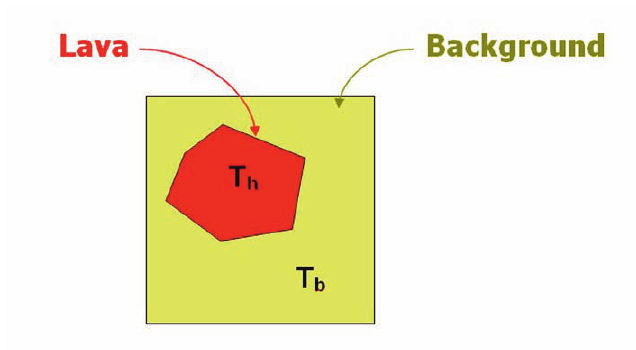
Figure 3. The dual-band method. This assumes that a pixel is occupied by two thermal components: a high-temperature component at temperature T that occupies a portion f of the pixel, surrounded by a cooler component h h that occupies the remainder (l − f at temperature T b